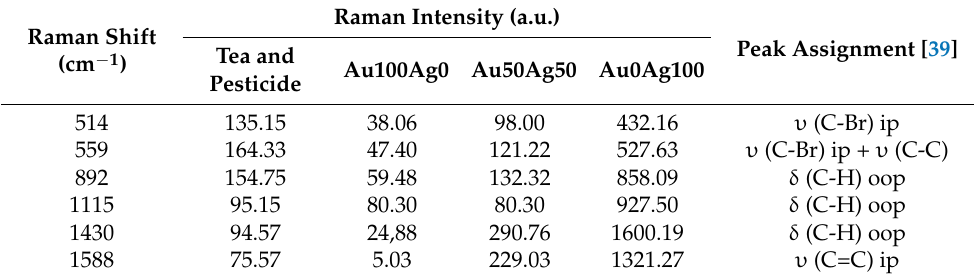
Table 1. The intensity of the Raman signal for deltamethrin pesticides. Raman Intensity Raman Shift